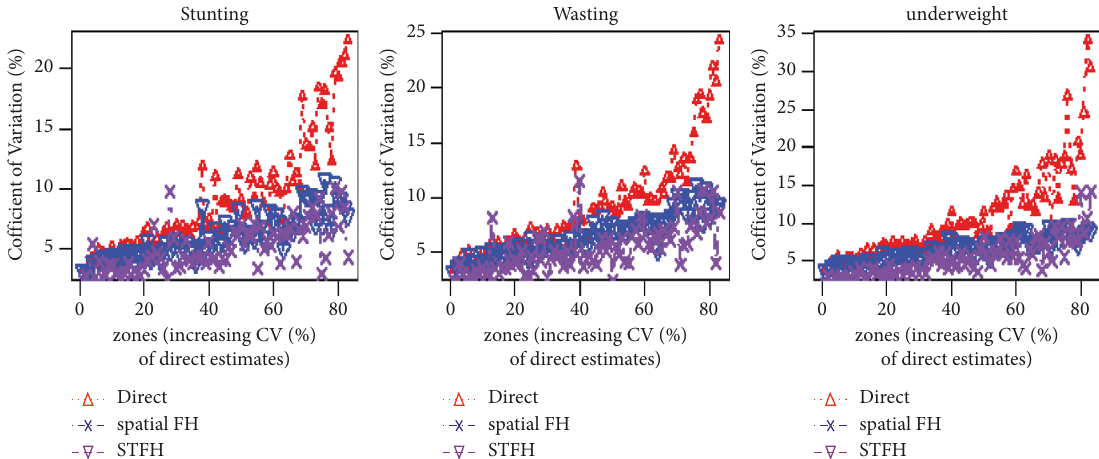
Figure 3: Zones percentage of coefficient of variation (CV) of direct, spatial FH, and STFH estimators of undernutrition